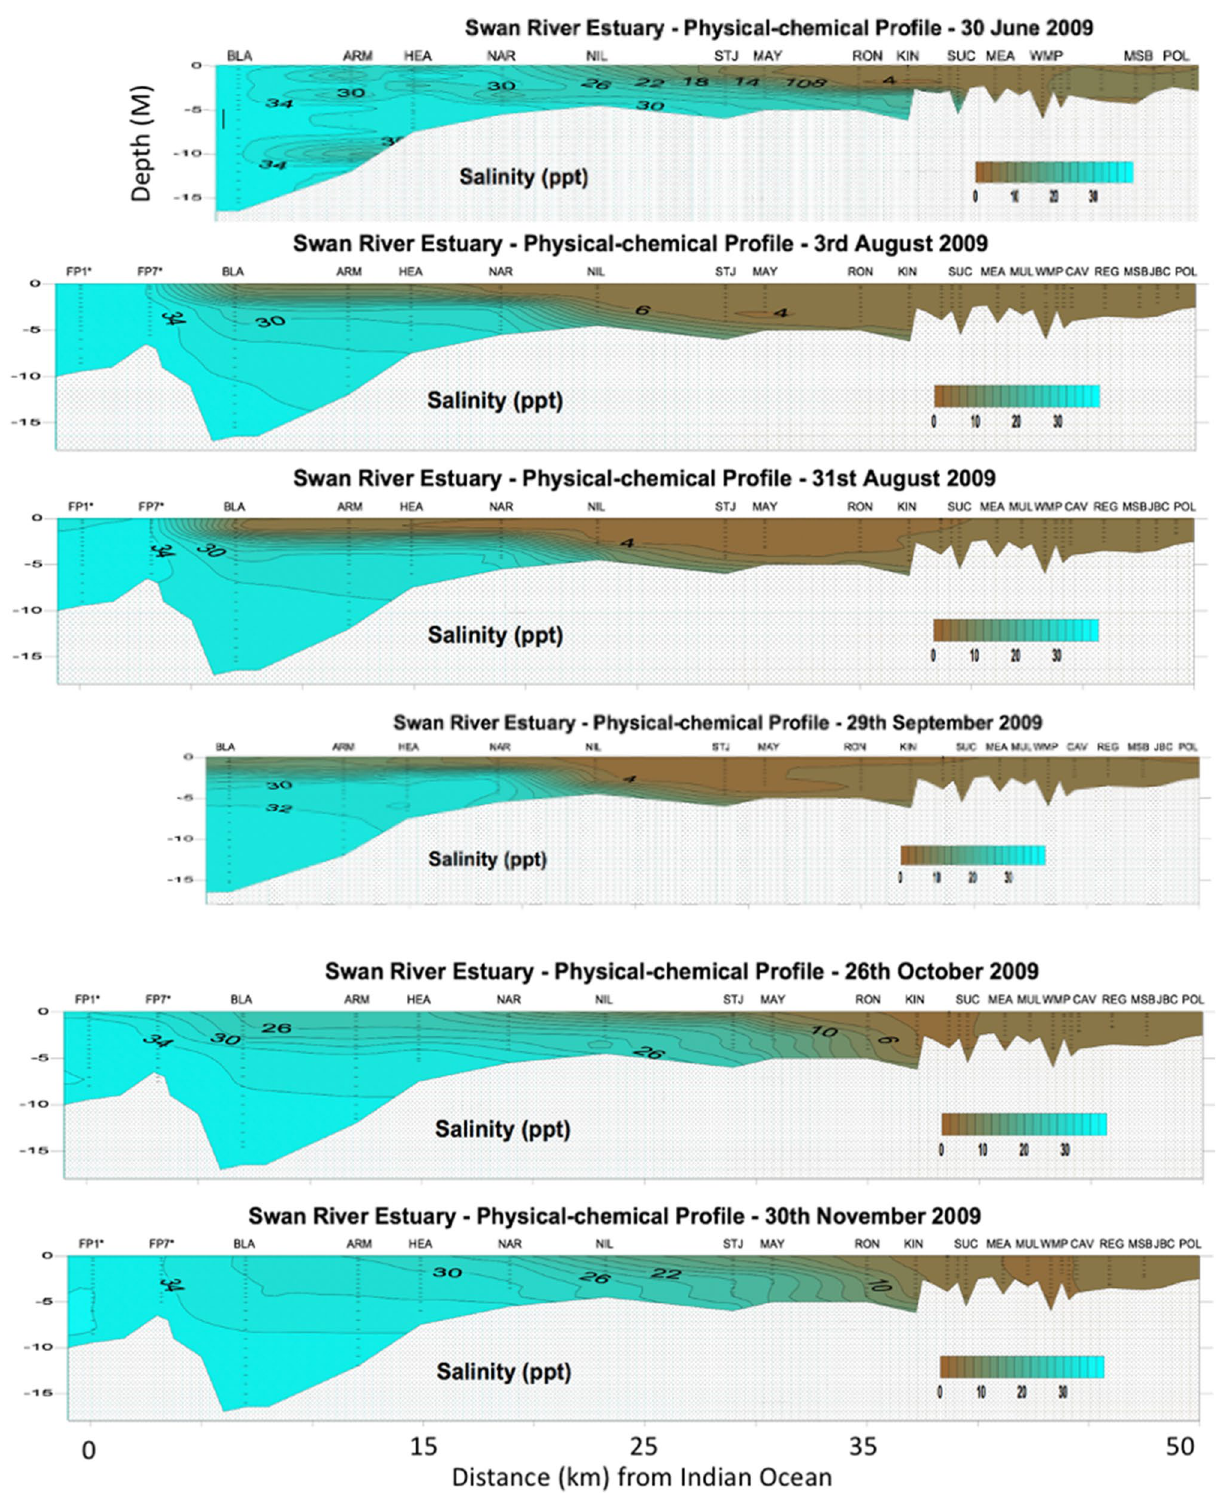
Figure 8. Temporal series of water salinity plots for up to 20 sampling stations (X axis top) at increasing distance from the Indian Ocean (0 on lower X axis) to 50 km upstream (right of figure). For reference to Fig. 1b, NAR is the Narrows Bridge. Fresh water (< 5 ppt) is represented as brown colors while marine water (> 25 ppt) is blue or green. Note that the surface water (up to 5 m depth) is predominantly fresh through the system from 3rd Aug. through 29th Sept. 2009. Prepared by the Department of Water and Environmental Regulation for the Department of Biodiversity, Conservation and Attractions, Western